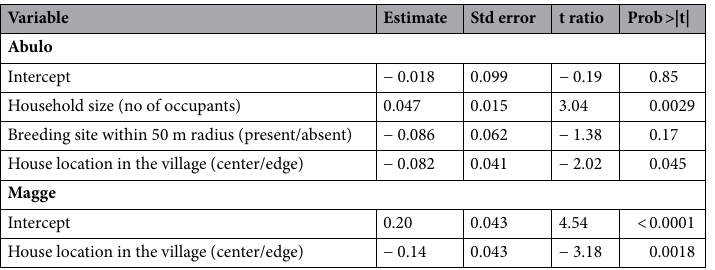
Table 3. Statistical summary of the effect of environmental variables on the incidence of malaria at the village level, following stepwise backward selection and removal of non-significant independent